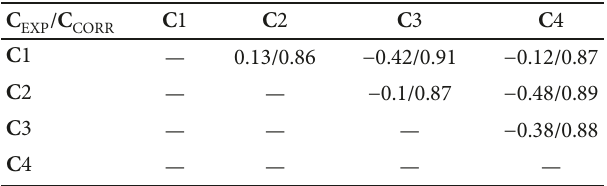
Table 1: Correlation between muscle activation coe ffi cients before ( C EXP ) and after the arti fi cial intervention ( C CORR ) to make them temporally correlated.